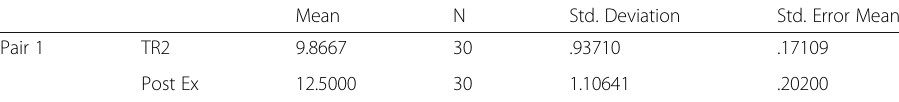
Table 17 Descriptive statistics of the Post-Ex and TR2 Mean Std. Deviation